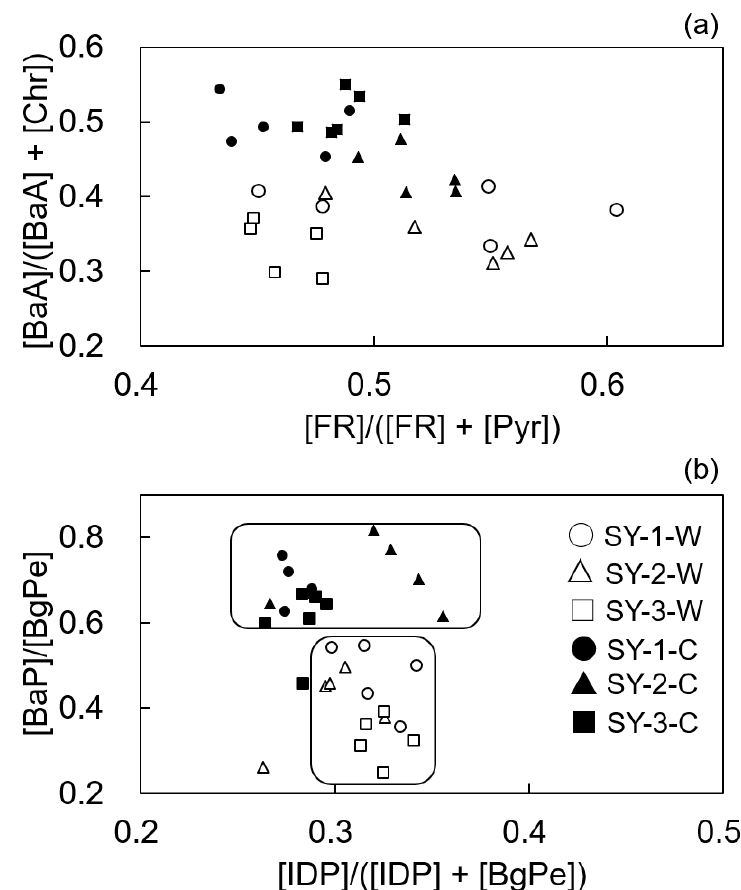
Figure 2. Diagnostic PAH ratios of all samples collected at the three sites in the warm and cold seasons. In ( a ), the X -axis represents [FR] / ([FR] + [Pyr]), and the Y -axis represents [BaA] / ([BaA] + [Chr]); In ( b ), the X -axis represents [IDP] / ([IDP] + [BgPe]), and the Y -axis represents [BaP] / [BgPe]. SY-1-W, SY-2-W and SY-3-W mean the ratios at three sites in the warm season; SY-1-C, SY-2-C and SY-3-C mean the ratios at three sites in the cold season. Table 2. Diagnostic ratios of PAH from previous